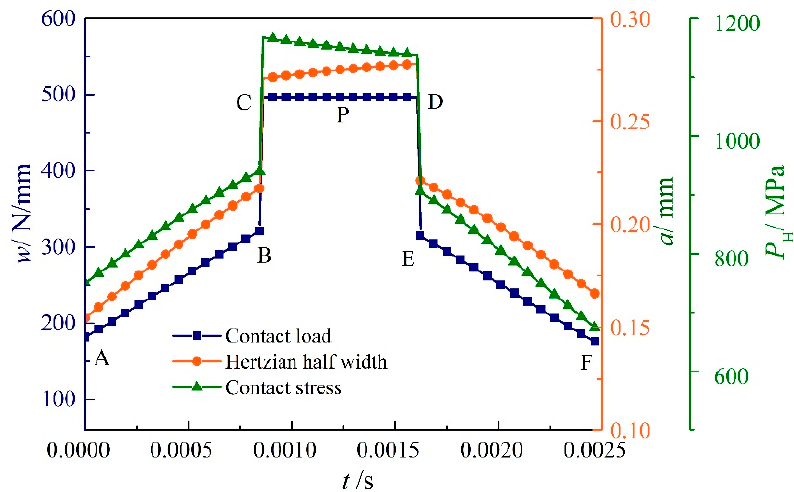
Figure 6. Gear contact parameter distribution.